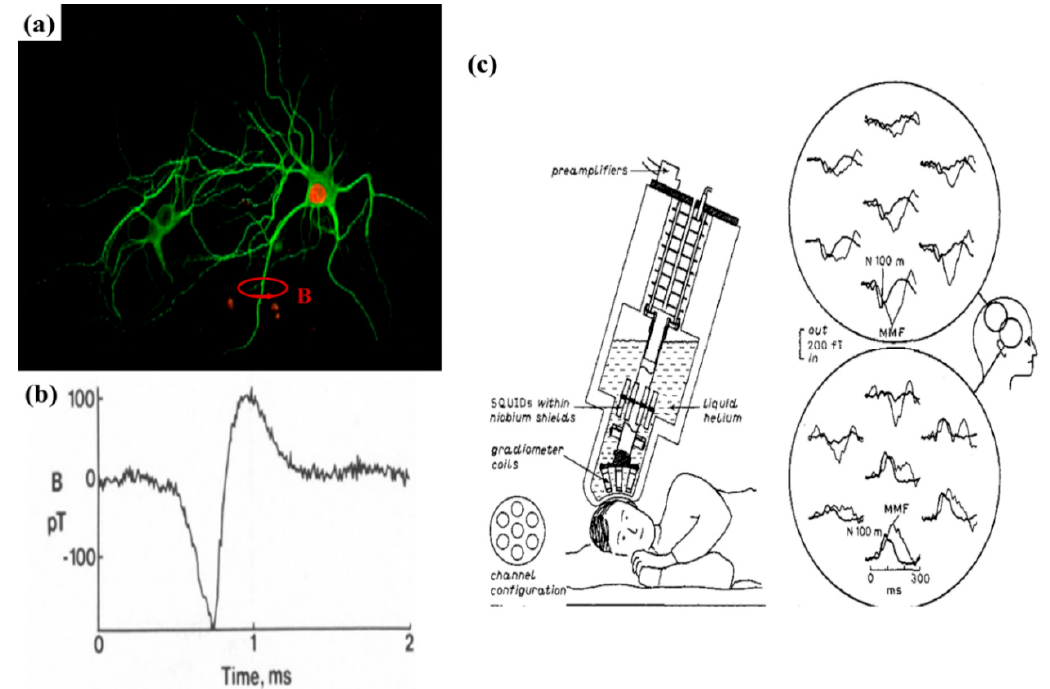
Figure 14. ( a ) The firing of neurons causes an ionic current to flow which according to the Biot-Savart Law generates a magnetic field (B) around the neurons that can be measured by magnetic sensors [143]; ( b ) the first recording of the magnetic field picked up from a single neuron with the help of a toroidal pick-up coil as reported by Roth and Wikswo [130]; ( c ) Superconducting Quantum Interference Devices (SQUID) system set up to record magnetic field from the cerebral cortex of the human brain. The circular insets show the real-time magnetic field recording from the brain [132]. ( a ) Reprinted under the terms of the Creative Commons Attribution 4.0 International License (CC BY). ( b ) Reprinted with permission from Elsevier 1985. ( c ) Reprinted with permission from IOP Publishing 1989.